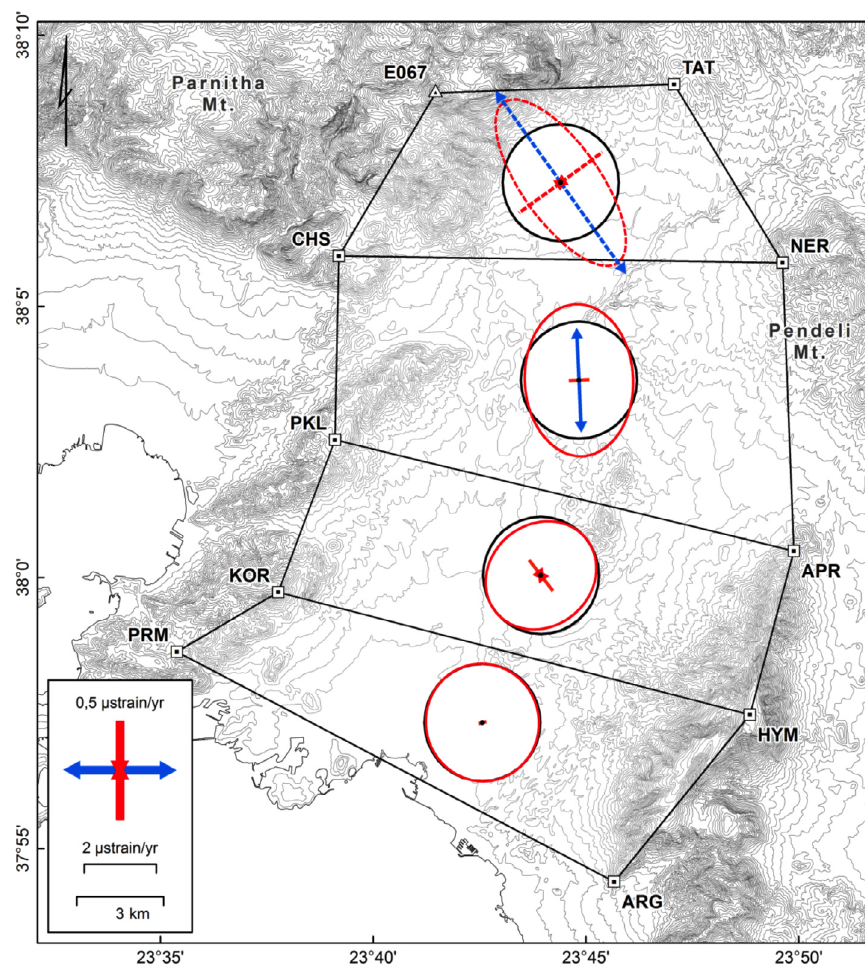
Figure 5. Principle axes of the strain rate tensors within Athens Basin. Dashed lines indicate local estimates around which GPS data are poorly distributed from a geometrical point of view. This figure shows negligible compressional rates at the southern part of the basin com- pared to the dominant extensional regime of gradually higher strain rates northwards up to 0.91 ±0.09 10 -6 yr -1 towards the northern part of the network between the Pendeli and Parnitha